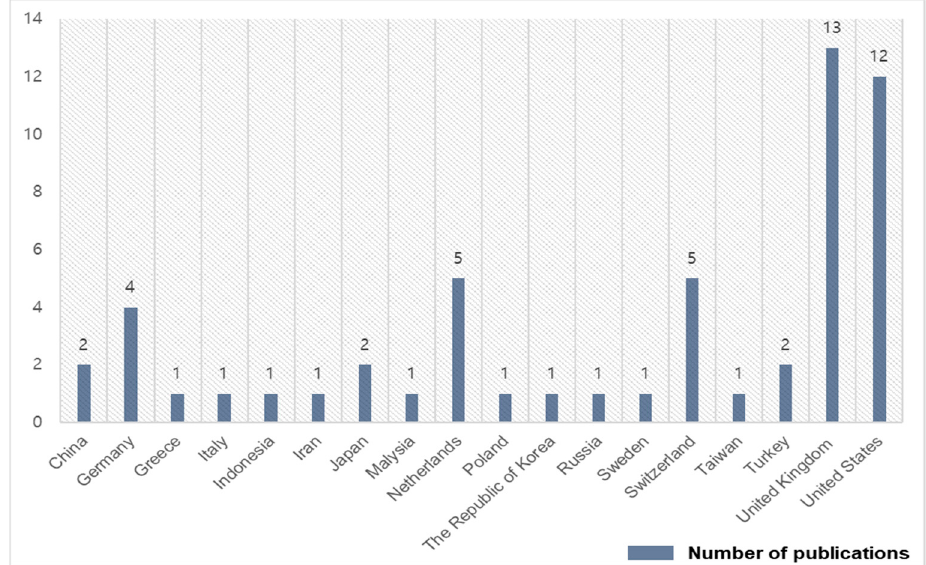
Figure 4. The number of papers published by country.